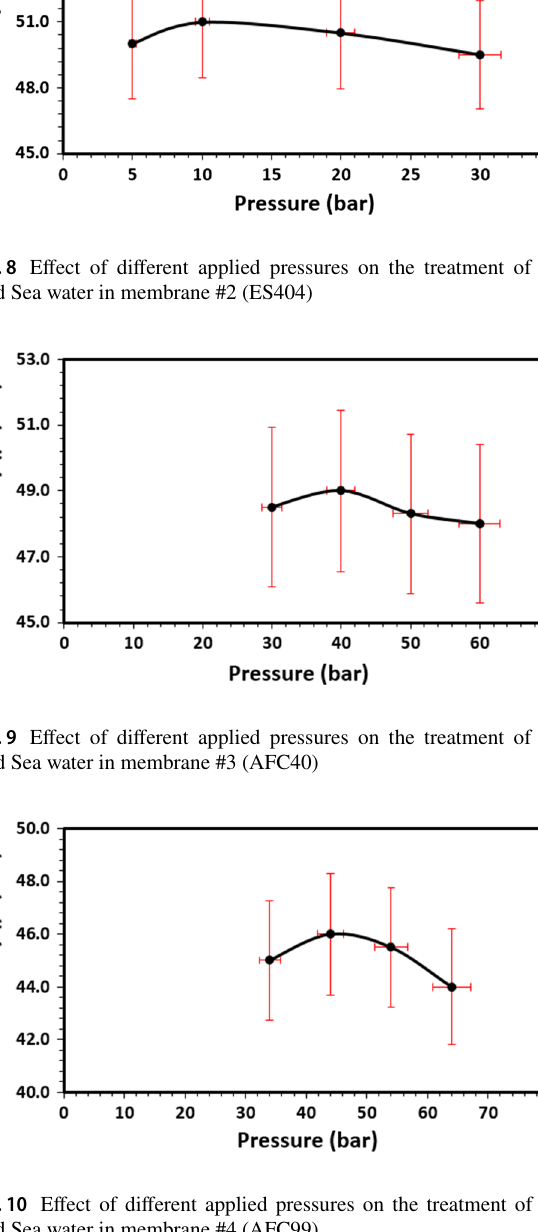
Fig. 10 Effect of different applied pressures on the treatment of the Red Sea water in membrane #4 (AFC99)